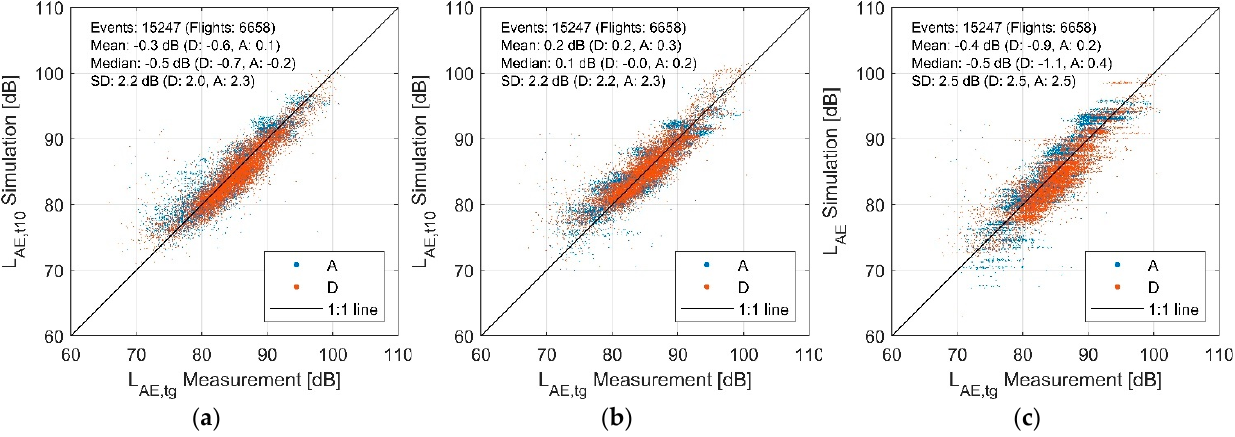
Figure 5. Scatter plots of simulation vs. measurements for aircraft without FDR data in the close range to the airports (ZRH and GVA combined), grouped by procedure (D: Departure, A: Approach, SD: Standard deviation). ( a ) sonAIR, ( b ) FLULA2, ( c ) AEDT.